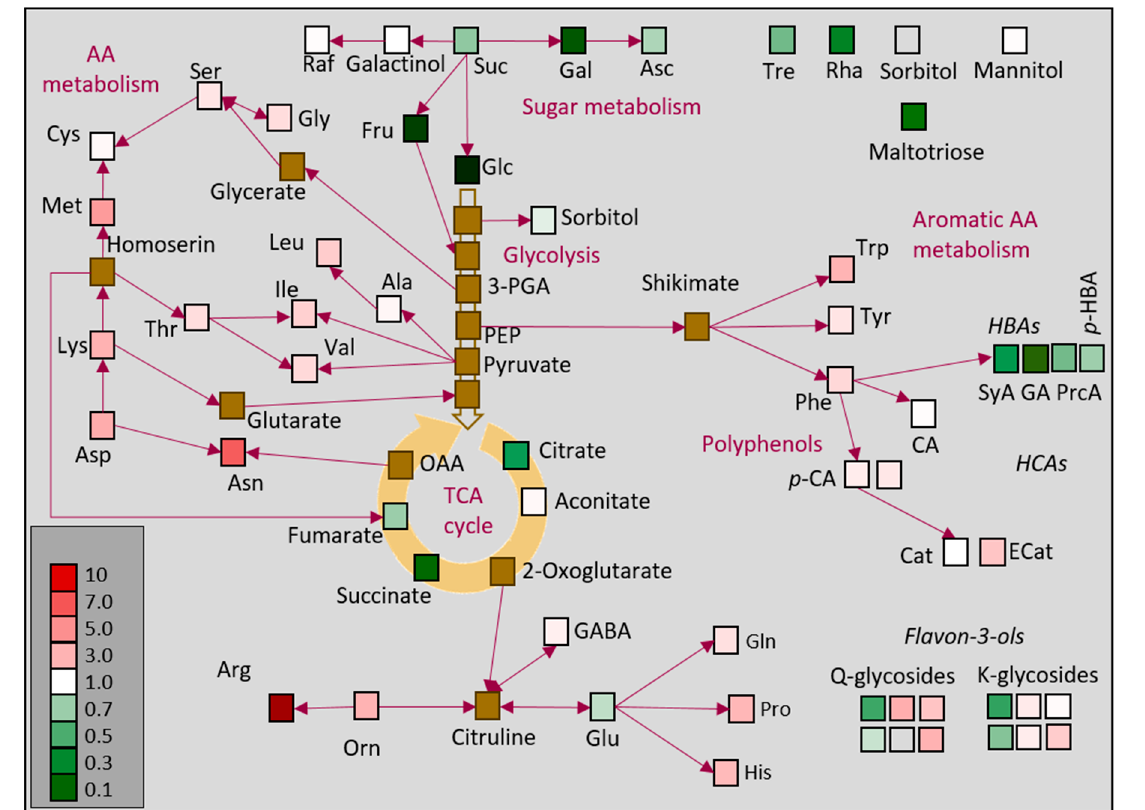
Figure 6. The main metabolic alterations of P. zonale GL and WL. The colours indicate the WL/GL for each identified metabolite. Important metabolites that were not determined are marked in brown. Asc, ascorbate; CA, caffeic acid; Cat, catechin; ECat, epicatechin; Fru, fructose; GA, gallic acid; GABA, γ -aminobutyric acid; Gal, galactose; Glc, glucose; HCA, hydroxycinnamic acids; K, kaempferol; OAA, oxaloacetate; p -HBA, p -hydroxybenzoic acid; p -CA, p -coumaric acid; 3-PGA, 3-phosphoglyceric acid; PEP, phosphoenol–pyruvate; PrcA, protocatechuic acid; Q, quercetin; Raf, raffinose; Rha, rhamnose; Suc, sucrose; SyA, syringic acid; TCA, tricarboxylic acid cycle; Tre, treha- lose.